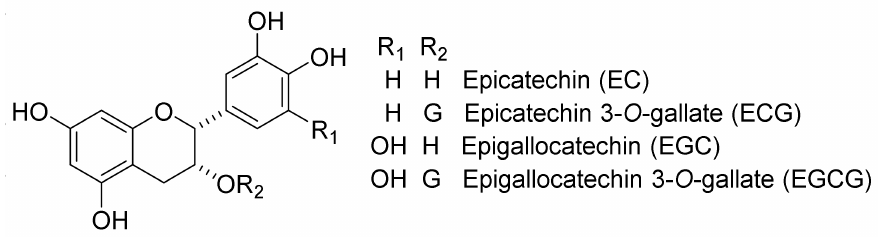
Figure 2. Chemical structures of EC, ECG, EGC, and EGCG.